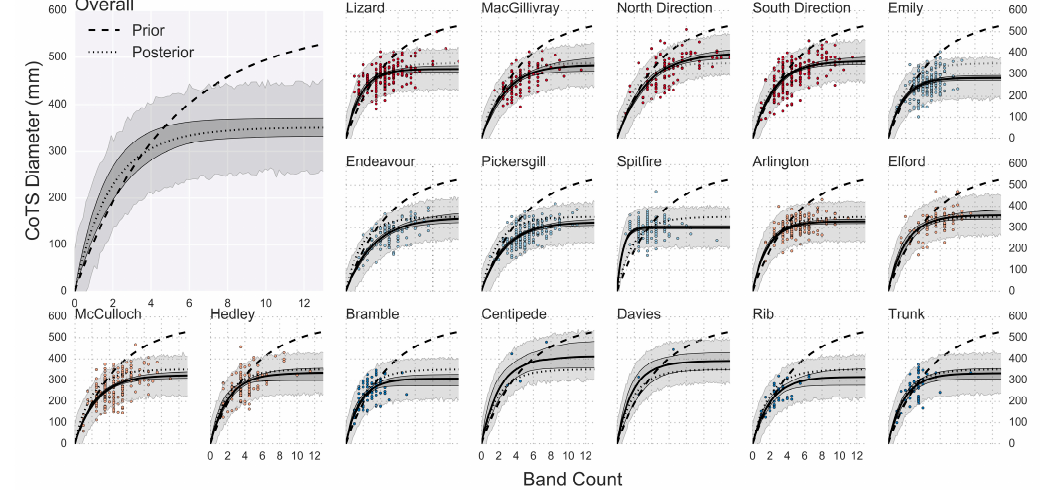
Figure 2. Bayesian hierarchical von Bertalanffy model posterior fit for the relationship between band counts and observed diameter of CoTS collected in the Great Barrier Reef CoTS initiation box, 2013–2014. Overall (grey panel, upper left) hierarchical posterior median von Bertalanffy curve (dotted line), 50% (dark grey area), and 95% (light grey area) uncertainty intervals (given highest posterior density); overall prior curve (dashed line) is from previous age and growth studies reported in [5]. Hierarchical model fits for each study reef (white panels) show inter-reef variation in posterior median curved (black lines) and uncertainty intervals, with points representing samples from the northern initiation box (red), central initiation box (light blue), southern initiation box (tan), and southern outbreak edge (dark blue).